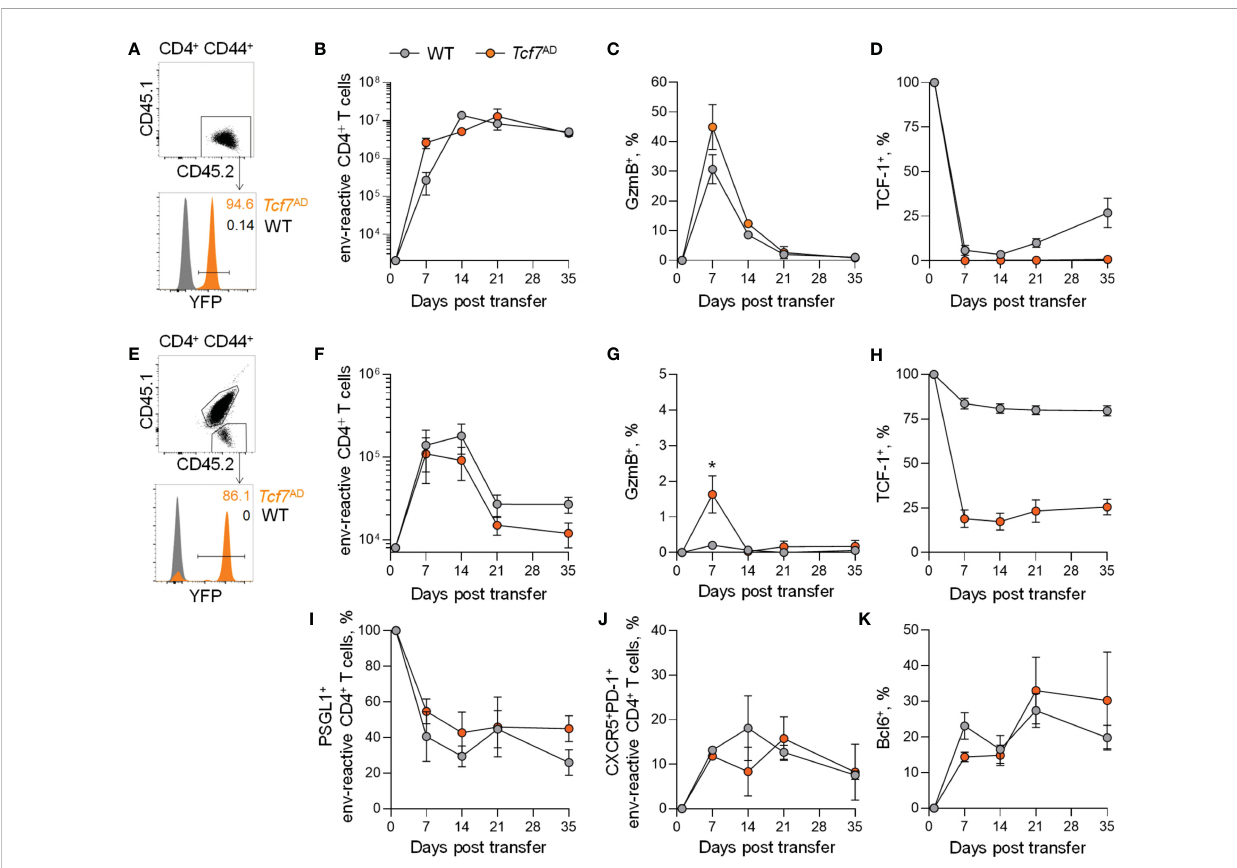
FIGURE 4 Memory CD4 + T cell, but not CTL maintenance independently of TCF-1. (A) Flow-cytometric detection of CD44 + env-reactive donor CD4 + T cells (top) and YFP + CD4 + T cells (bottom) in spleens of Rag1 -/- recipient mice. (B) Absolute numbers of WT EF4.1 and Tcf7 AD EF4.1 env-reactive donor CD4 + T cells in the spleens of FV-infected Rag1 -/- recipient mice at indicated time points after adoptive transfer. (C) GzmB expression and (D) TCF-1 expression of WT EF4.1 and Tcf7 AD EF4.1 env-reactive donor CD4 + T cells in the spleens of FV-infected Rag1 -/- recipient mice at indicated time points after adoptive transfer. (E) Flow-cytometric detection of CD44 + env-reactive donor CD4 + T cells (top) and YFP + CD4 + T cells (bottom) in spleens of WT recipient mice. (F) Absolute numbers of WT EF4.1 and Tcf7 AD EF4.1 env-reactive donor CD4 + T cells in the spleens of FV-infected WT recipient mice at indicated time points after adoptive transfer. (G) GzmB expression and (H) TCF-1 expression of WT EF4.1 and Tcf7 AD EF4.1 env- reactive donor CD4 + T cells in the spleens of FV-infected WT recipient mice at indicated time points after adoptive transfer. (I) PSGL-1 expression of WT EF4.1 and Tcf7 AD EF4.1 env-reactive donor CD4 + T cells in the spleens of FV-infected WT recipient mice at indicated time points after adoptive transfer. (J) Frequency of CXCR5 + PD-1 + and (K) Bcl6 + cells within total WT EF4.1 and Tcf7 AD EF4.1 env-reactive donor CD4 + T cells in the spleens of FV-infected WT recipient mice at indicated time points after adoptive transfer. *p <